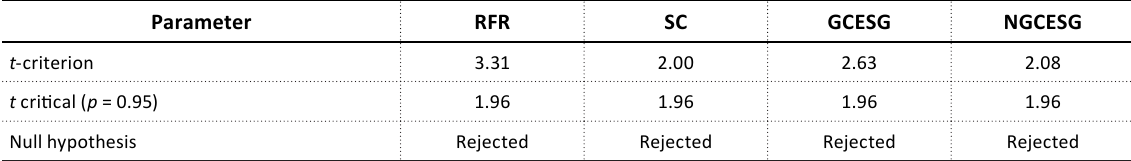
Table C1. T -test of the differences between developed countries and developing and emerging countries Parameter RFR SC GCESG NGCESG